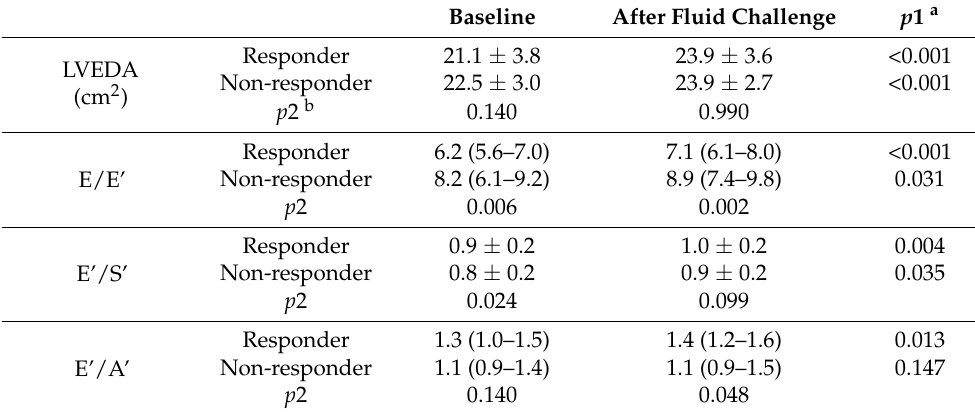
Table 3. Echocardiographic preload indices at baseline and after fluid